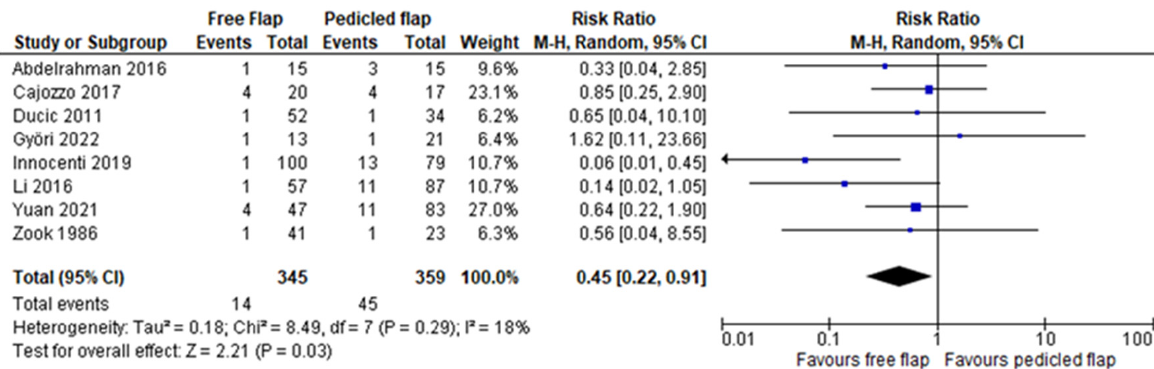
Figure 4. Overall complications meta-analysis [13,15,16,19–21]. Figure 5. Revision surgery meta-analysis [13,15,16,19,21].